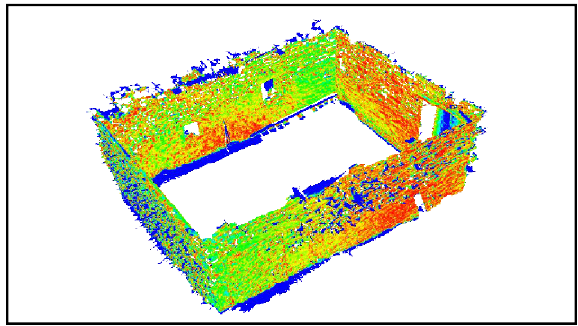
Figure 6. Comparison between laser scanner and photo- modelling 3D models: from red (indicating a